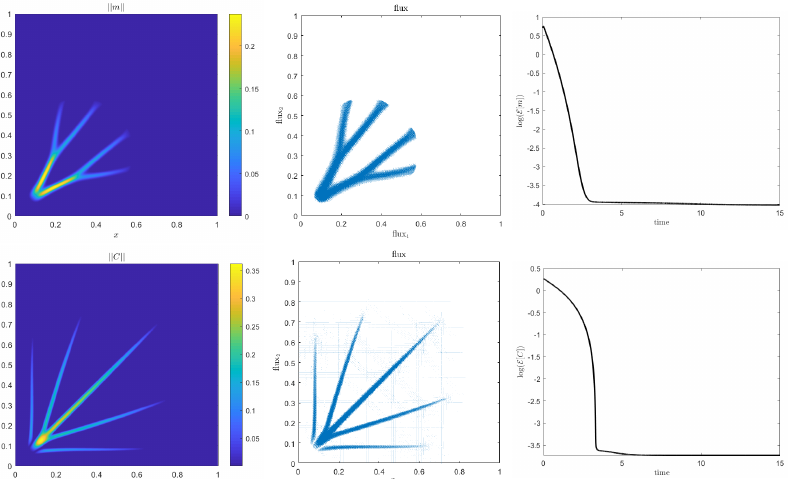
Figure 1. In this figure, we show three different quantities of the same computations, with the parameters defined in T EST D: the module of the variables at final time ( left panels ), the flux also at final time ( central panels ) and the energy as a function of time ( right panels ). The first row concerns variable m , and the second one is for variable C .